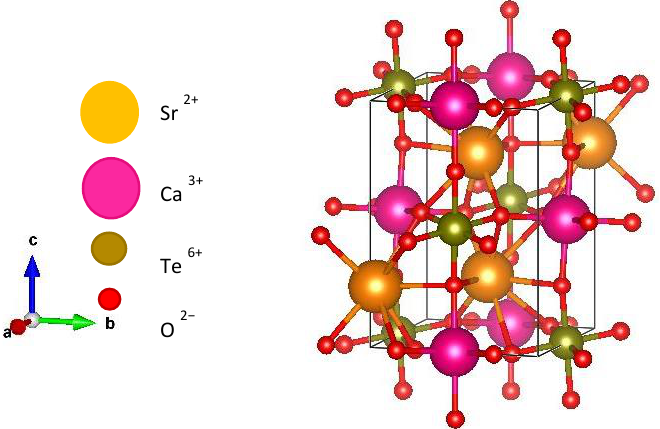
Figure 2. Image of refined XRD in Sr 2 CaTeO 6 from bc plane.